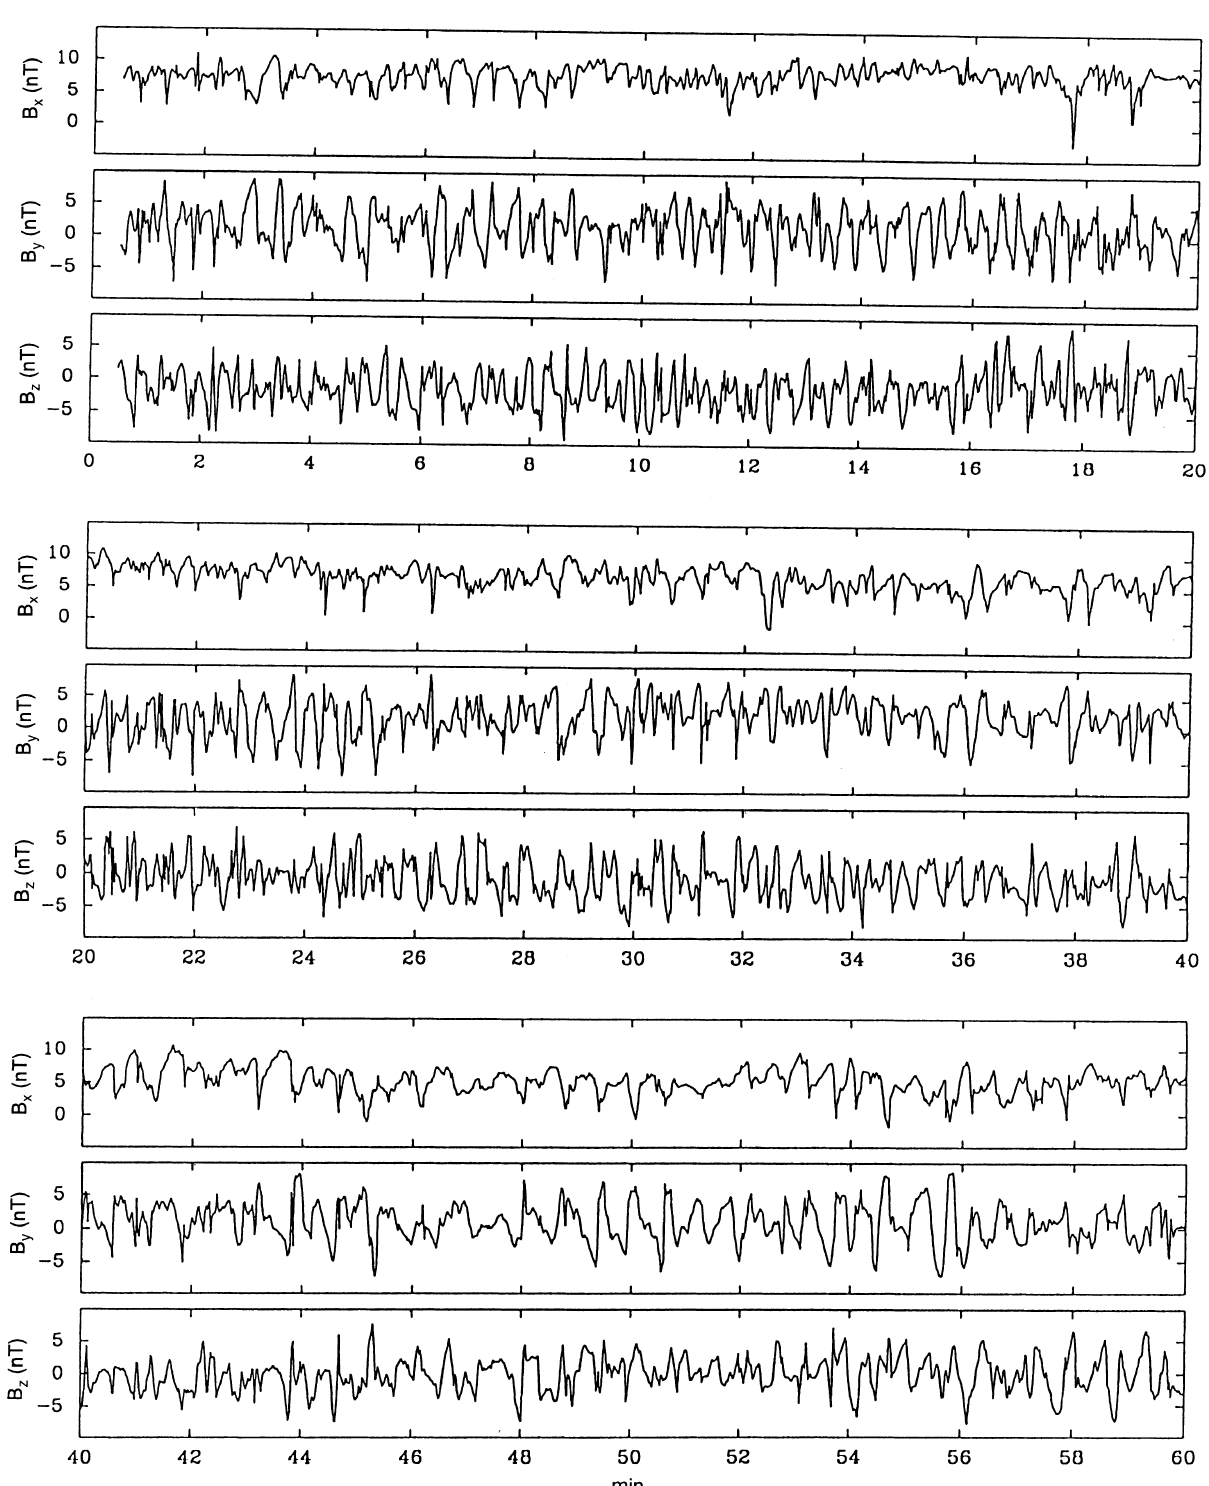
Fig. 7. High-resolution (1.28-s) IMP-8 data of the interplanetary magnetic field for the interval 0800–0900 UT, 18 June